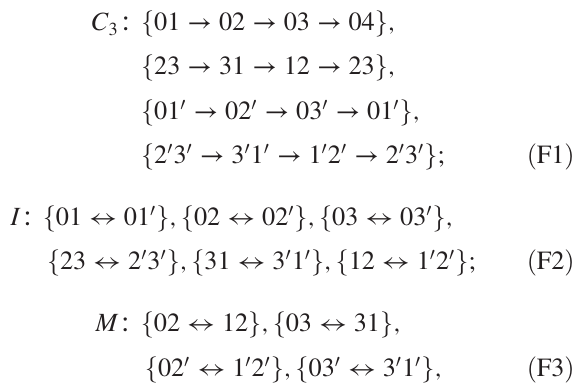
ˆ D α ˆ D 01 ˆ D 01 ˆ D α FIG. 11. Bond-bond dimer correlations h j i - h j i 0 0 ih resolved in real space and measured on the 4 × 4 3 cluster within SU ð 2 Þ mVMC at j =j 0 . The distance j r − r 2 1 ¼ 0 j j is between the origins of the unit cells 0 and j , and the index α runs over the 12 bonds in a unit cell as introduced in Sec. III D and in Fig. 10. Shaded regions indicate the mean and standard deviation of the measured correlations. The point r 0 ¼ r j is omitted due to the big difference with the other